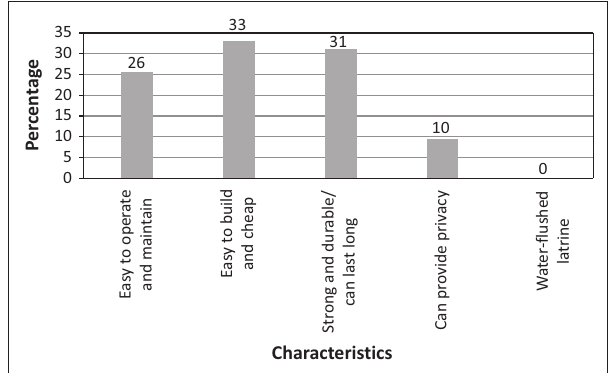
FIGURE 13: Required characteristics of a